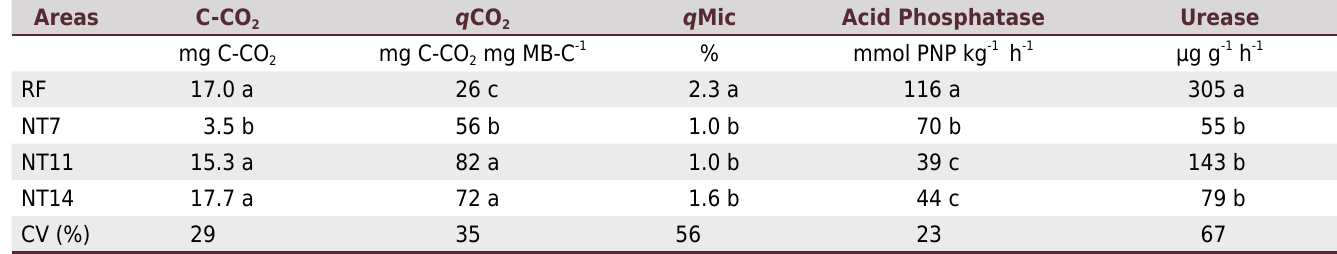
Table 3. Basal soil respiration (CO 2 ), metabolic quotient (qCO 2 ), microbial quotient (qMic), acid phosphatase, and urease in no-tillage chronosequence areas and in Murundus field (reference)